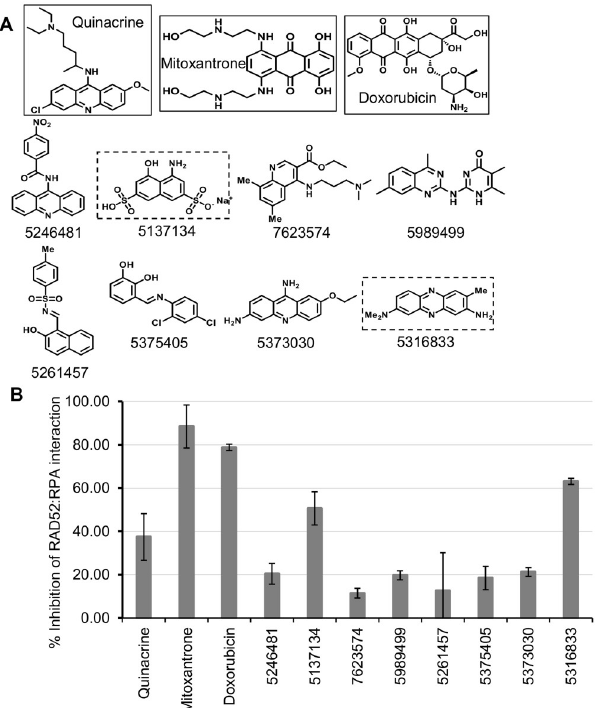
Fig 1. Identification and characterization of RPA:RAD52 inhibitors. (A) Chemical structures of the top eleven FluorIA hits. The strongest inhibitors are boxed (FDA-approved in solid-line, Chembridge dashed-line). (B) Comparison of hits for the inhibition of the RPA:RAD52 interaction at a single concentration (62.5 μ M). The FluorIA inhibition data for the full concentration range for each hit was included in S1 Fig.